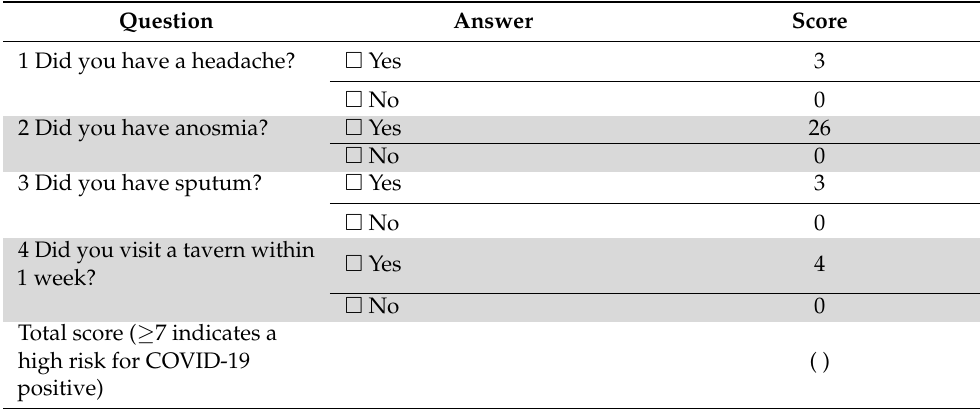
Table 5. Development of COVID-19 scoring